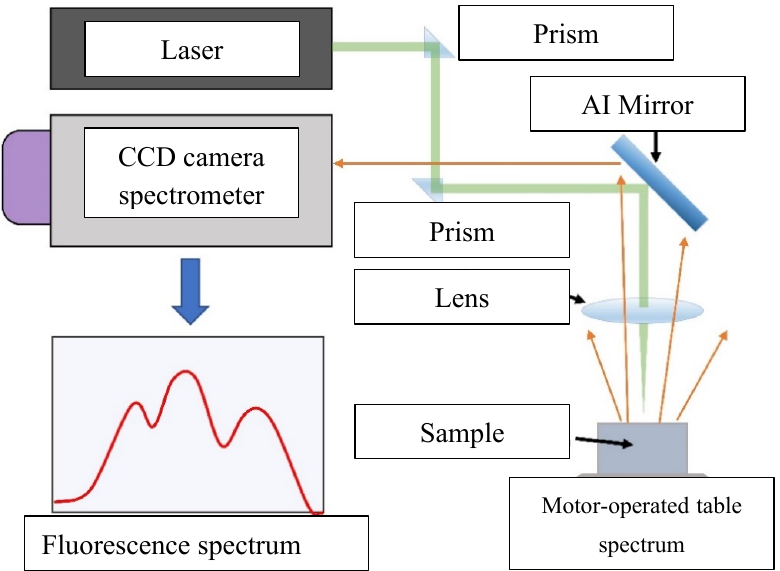
Figure 4. Schematic diagram of experimental installation for recording fluorescence spectra based on the Raman lidar.